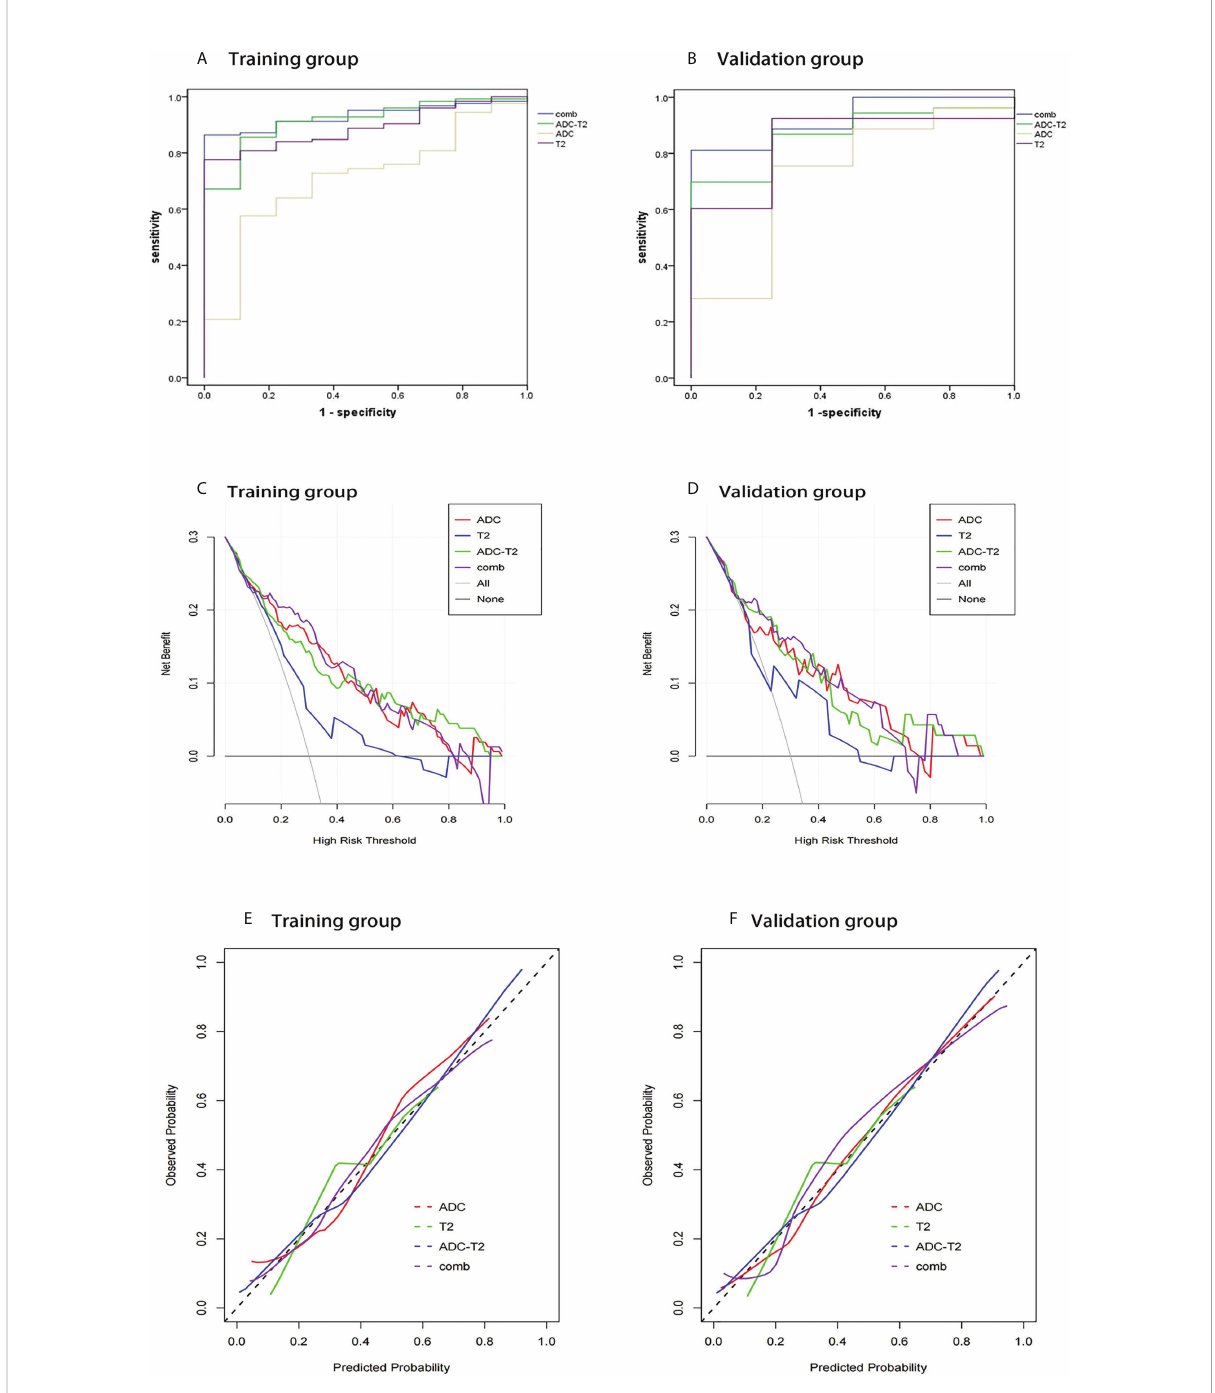
FIGURE 3 ROC curves, decision curve analysis, calibration curves for different models in the training and validation groups. The ROC curves for the four models in the training and validation groups are shown in (A, B) . The decision curves for the four models in the training and validation groups are shown in (C, D) . The calibration curves for the four models are shown in (E, F)